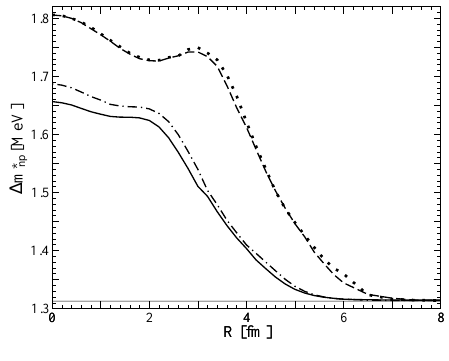
Fig. 5. The dependence of the total in-medium neutron-proton on the distance R between the center of the mass di ff erence ∆ m ∗ np skyrmion and the center of the nucleus. The notations and input are the same as in Fig. 2, with the exception that the horizontal line marks the free space value ∆ m np = 1 . 3 MeV. Figure from Ref.